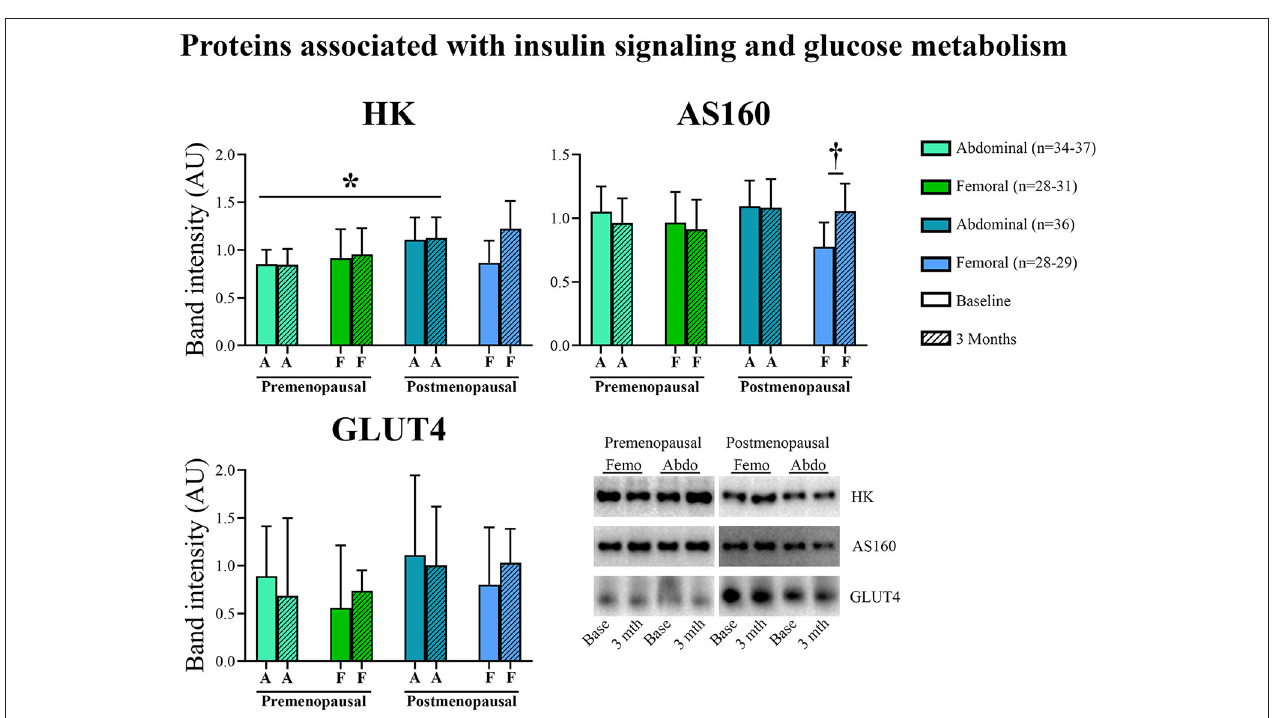
FIGURE 4 | Abundance of proteins associated with insulin signaling and glucose metabolism in abdominal and femoral subcutaneous adipose tissue in pre- and post-menopausal woman before and after 3 months of high-intensity training. In abdominal adipose tissue, HK content was higher in post- compared to pre-menopausal women. In femoral adipose tissue, exercise training increased AS160 content in post-menopausal women. Changes from baseline to 3 months † p ≤ 0.05. Difference between groups * p ≤ 0.05. HK and AS160 protein abundances are presented as mean (95% confidence limits). GLUT4 protein abundance is presented as median (25–75 percentile). HK, Hexokinase; AS160, Akt substrate 160 kDa; GLUT4, Glucose transporter 4.